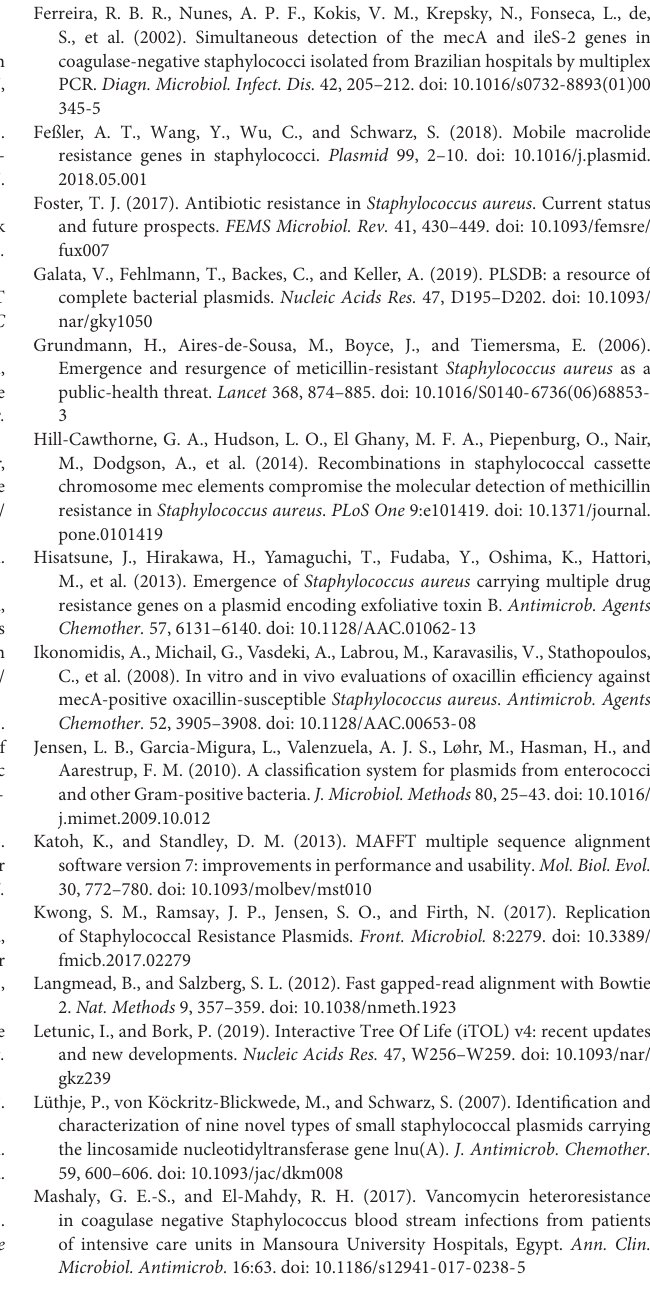
Supplementary Table 3 | Annotation of putative plasmid sequences. Supplementary Table 4 | Antibiotic resistance genes identified for each putative plasmid